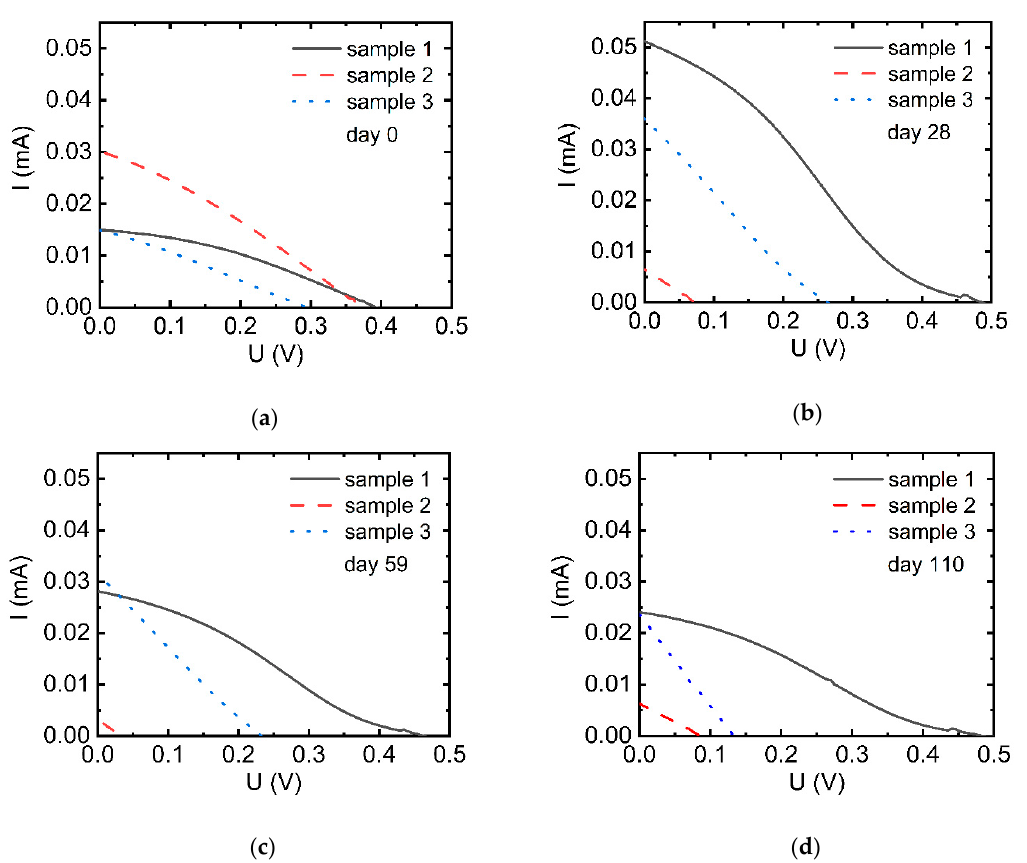
Figure 3. I-U curves of PAN blended with PEO (samples 1 and 2) and PAN (sample 3) GPEs for: ( a ) day 0; ( b ) day 28; ( c ) day 59; and ( d ) day 110.